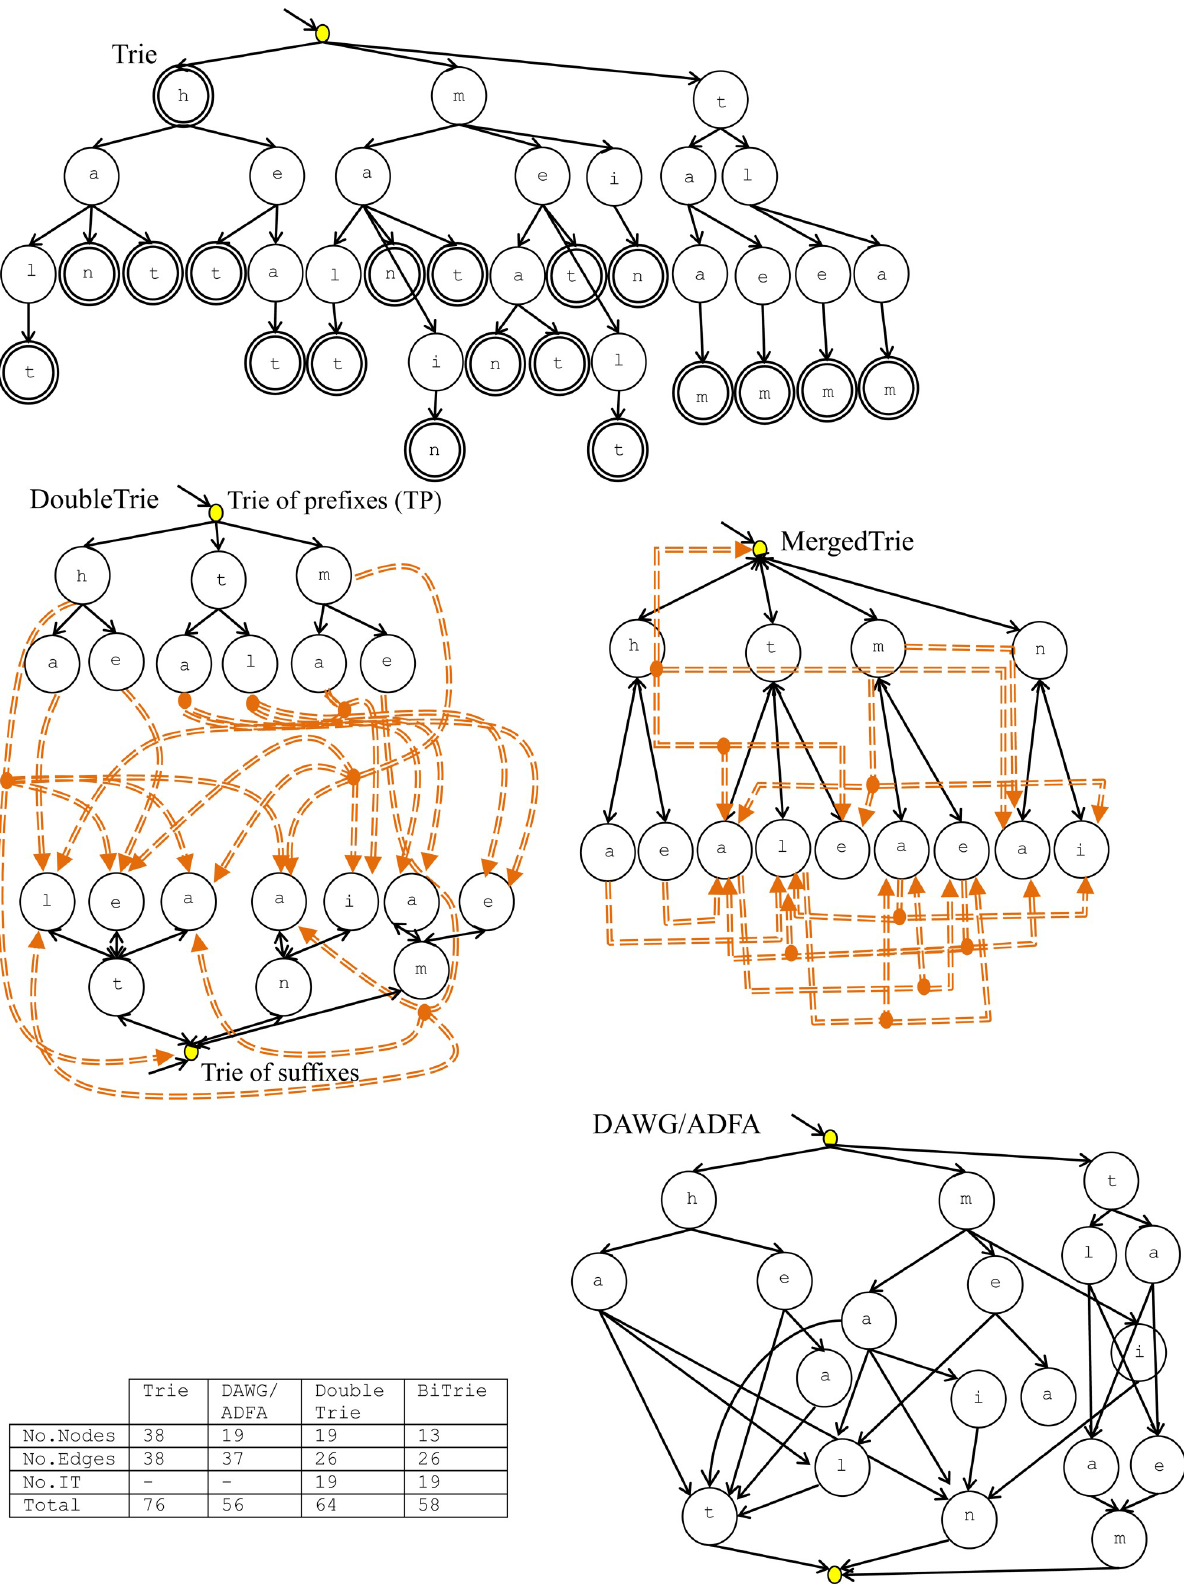
Fig 1. Trie, Double Trie, MergedTrie, and DAWG/ADFA formed by 19 words: h, hat, halt, han, heat, het, main, malt, man, mat, met, meat, mean, melt, min, taam, taem, tlam, tlem. https://doi.org/10.1371/journal.pone.0215288.g001 PLOS ONE | https://doi.org/10.1371/journal.pone.0215288 April 23,